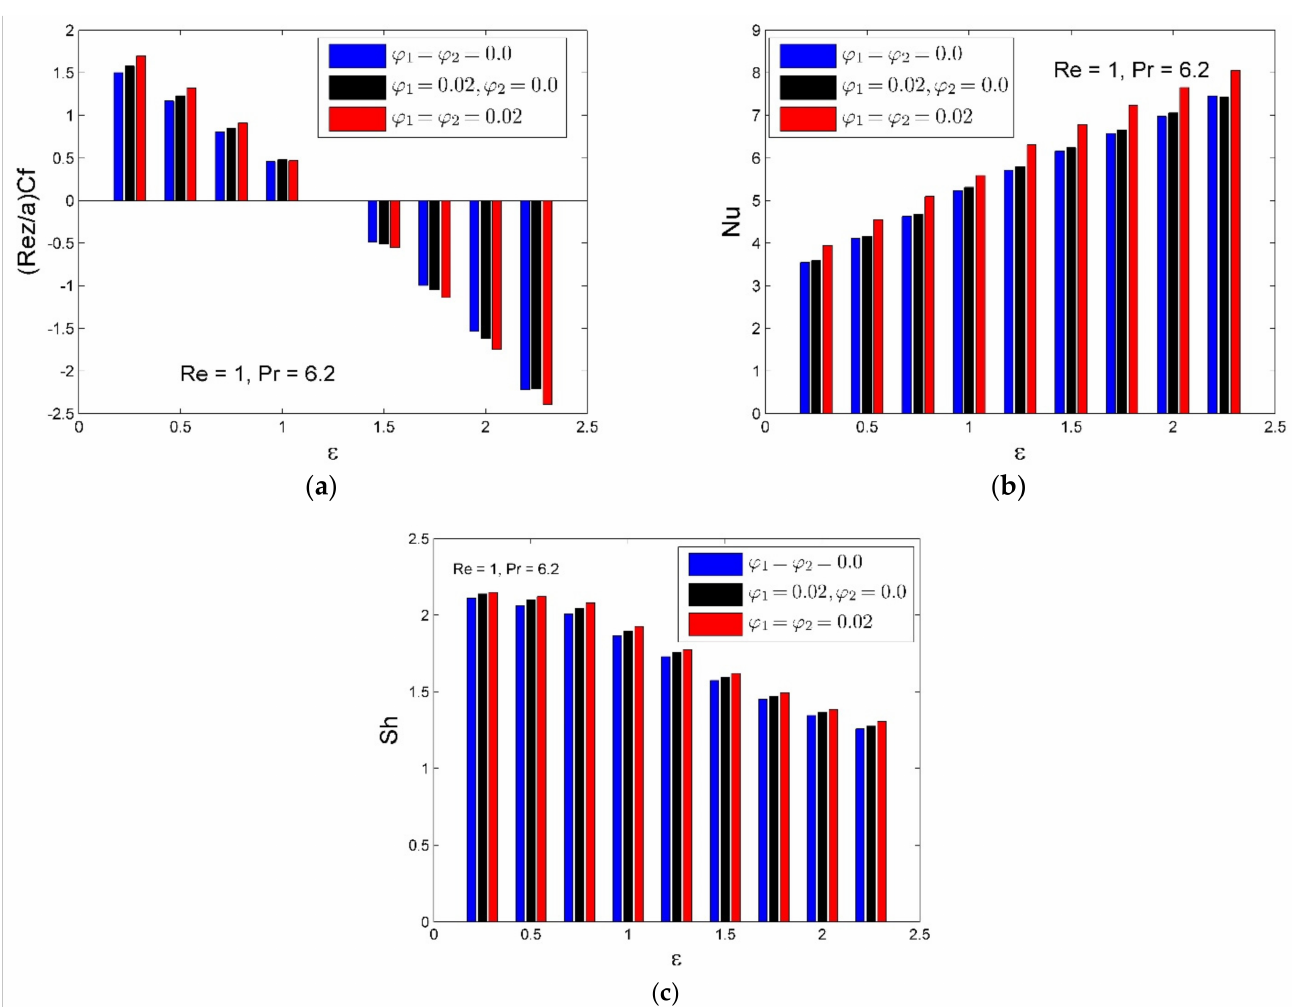
Figure 7. Influences of ϕ 1 and ϕ 2 on C f , Nu, and Sh